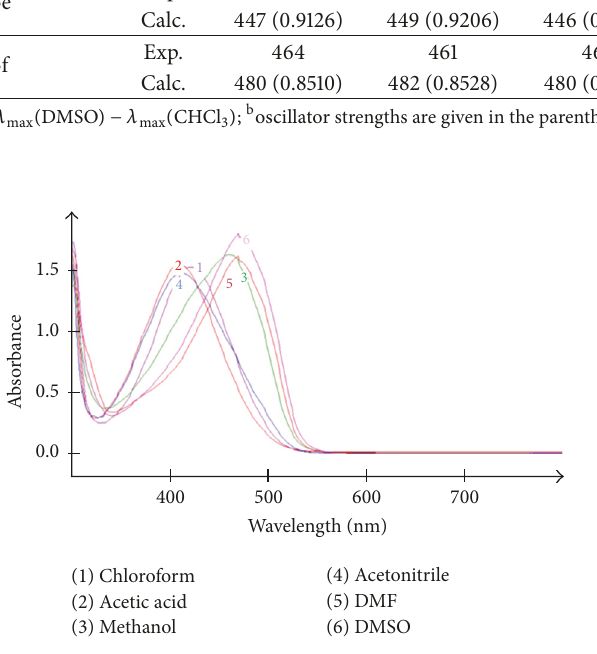
Figure 5: Absorption spectra of dye 3b in various